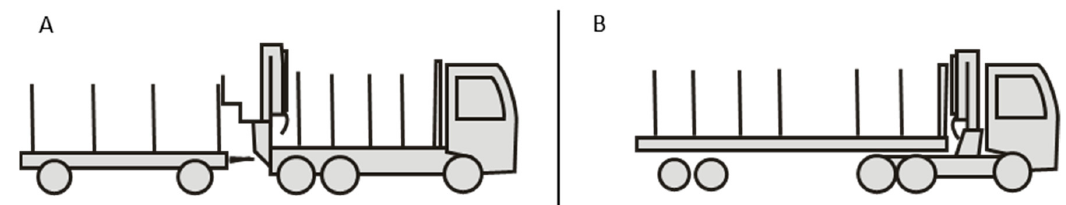
Figure 11. Schematic display of ( A ) self-loading combined truck with short wood trailer providing a lorry length of 2 × 5.1 m and lorry width of 2.27 m and ( B ) self-loading truck with long trailer and a lorry length of 13 m and lorry width of 2.4 m (adapted from [20]).